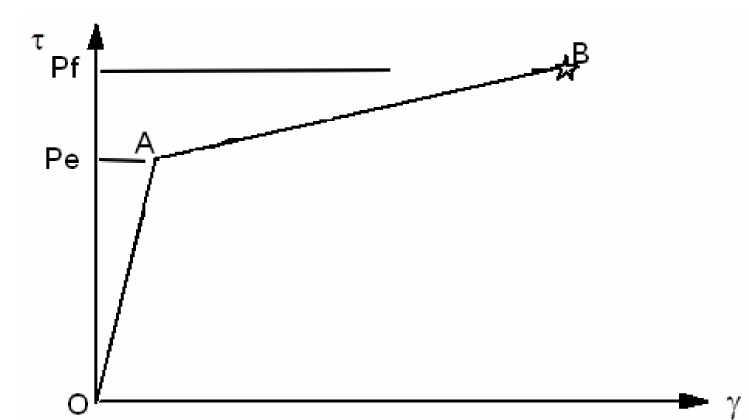
Figure A1. Geometry and notation for adhesive bonded double lap joint.